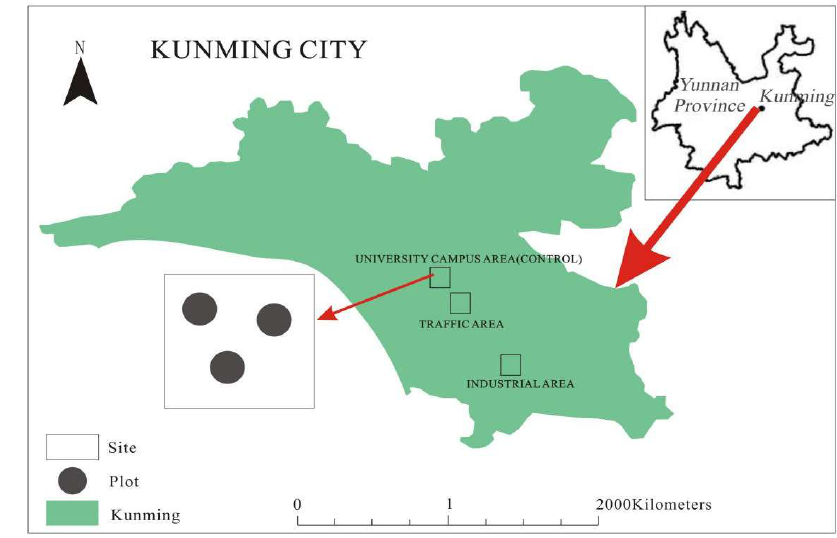
Figure 2. Site arrangement in this study. Table 2. Environmental conditions across the three functional zones (industrial, traffic and university campus) in Kunming City, Southwest China.